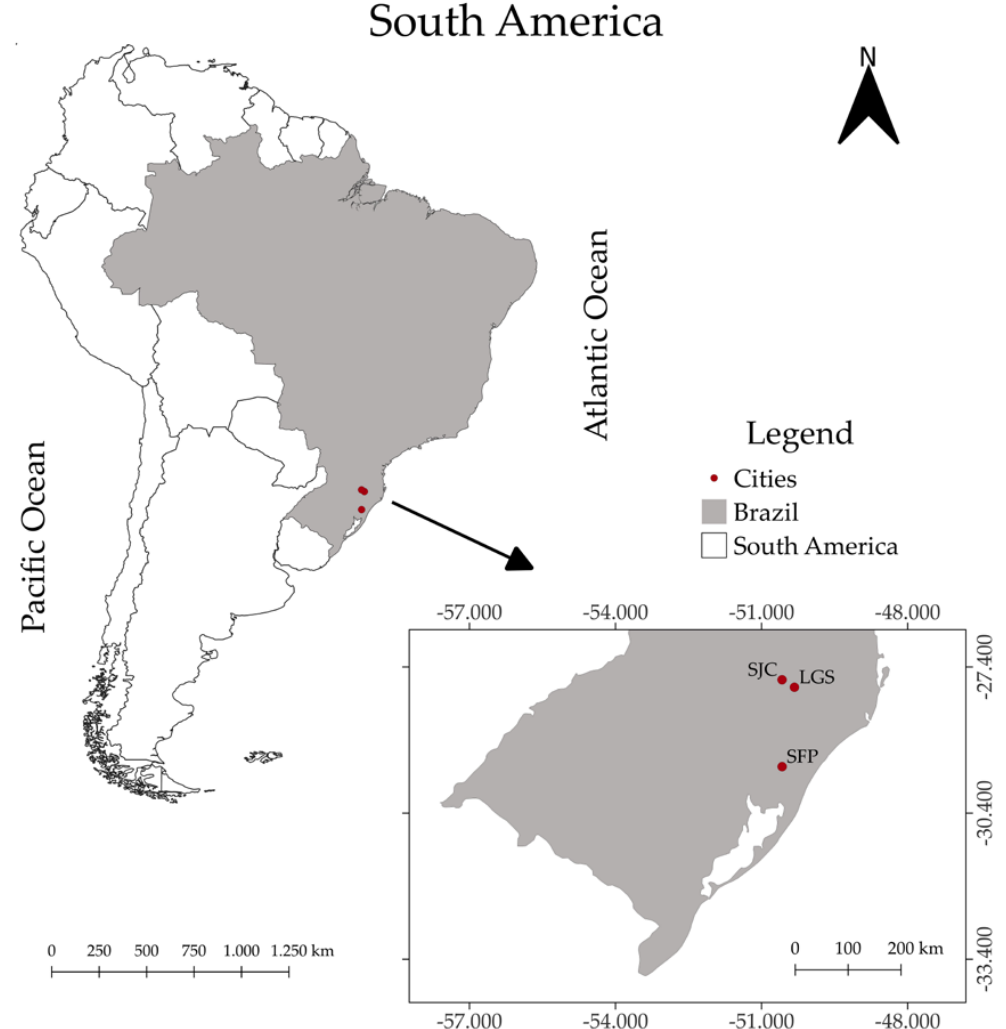
Figure 1. Study areas in different locations in southern